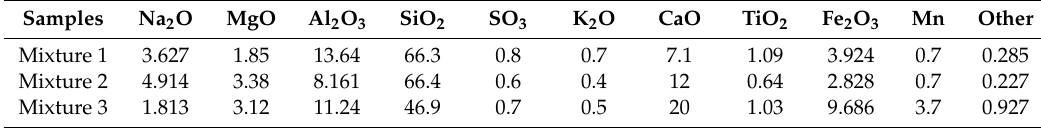
Figure 5. Schematic diagram showing the heat treatment and annealing processes for the production of glass-ceramics: ( a ) Mixture 1, ( b ) Mixture 2, and ( c ) Mixture 3. Table 2. Composition of mixtures investigated (mol